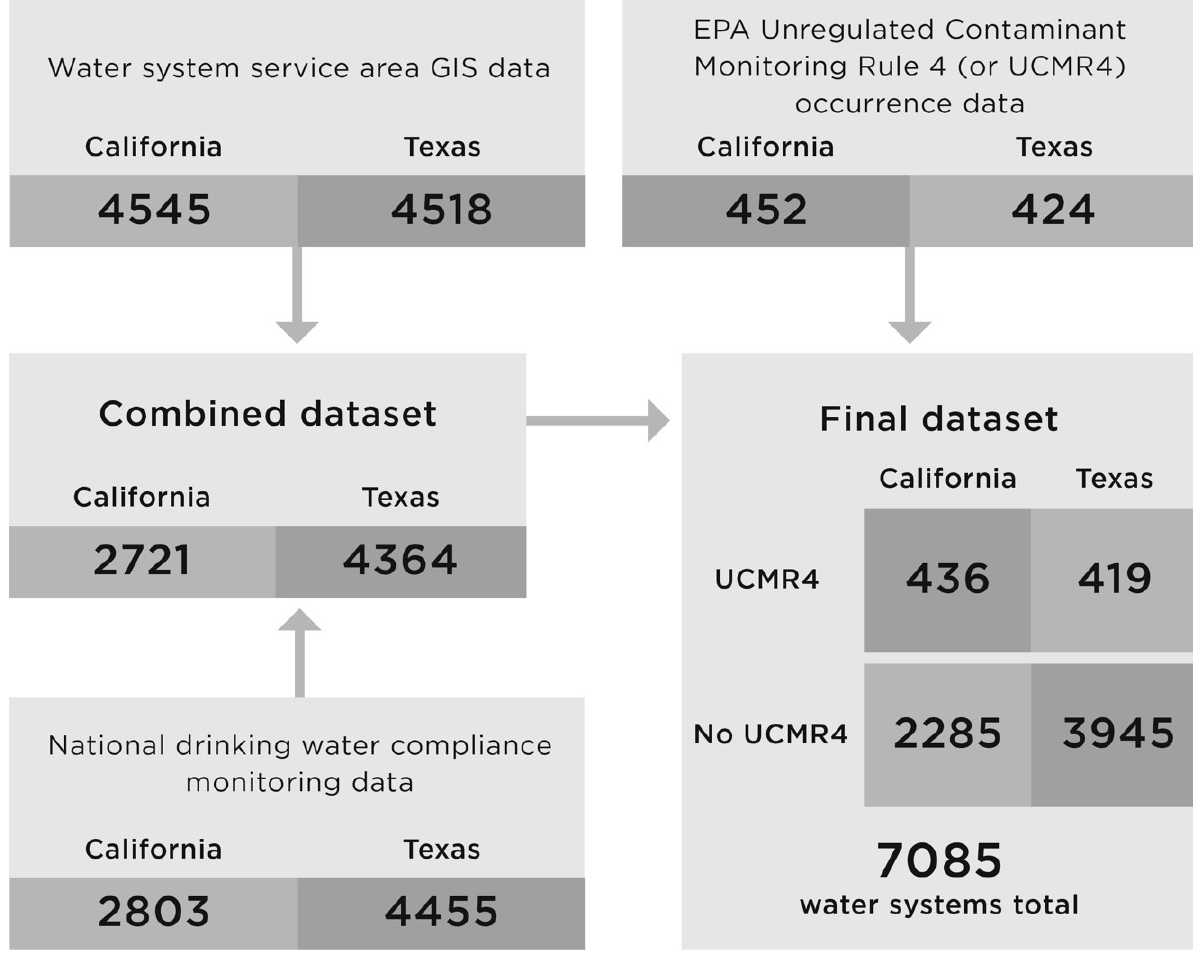
Figure 3. Contaminant occurrence and GIS service area data availability for community water systems in California and Texas . The flow chart shows the number of systems with specific data and the number of systems in the final combined data set.